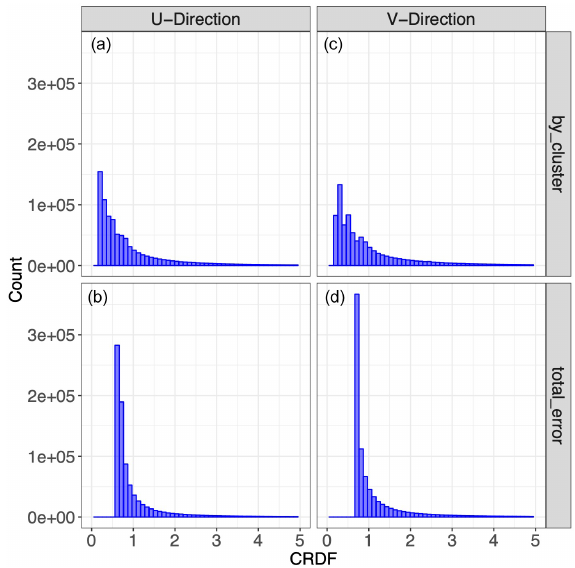
Figure 16. CRPS applied to different error approaches. (a) Cluster errors for u winds; (b) total errors for u winds; (c) cluster errors for v winds; (d) total errors for v